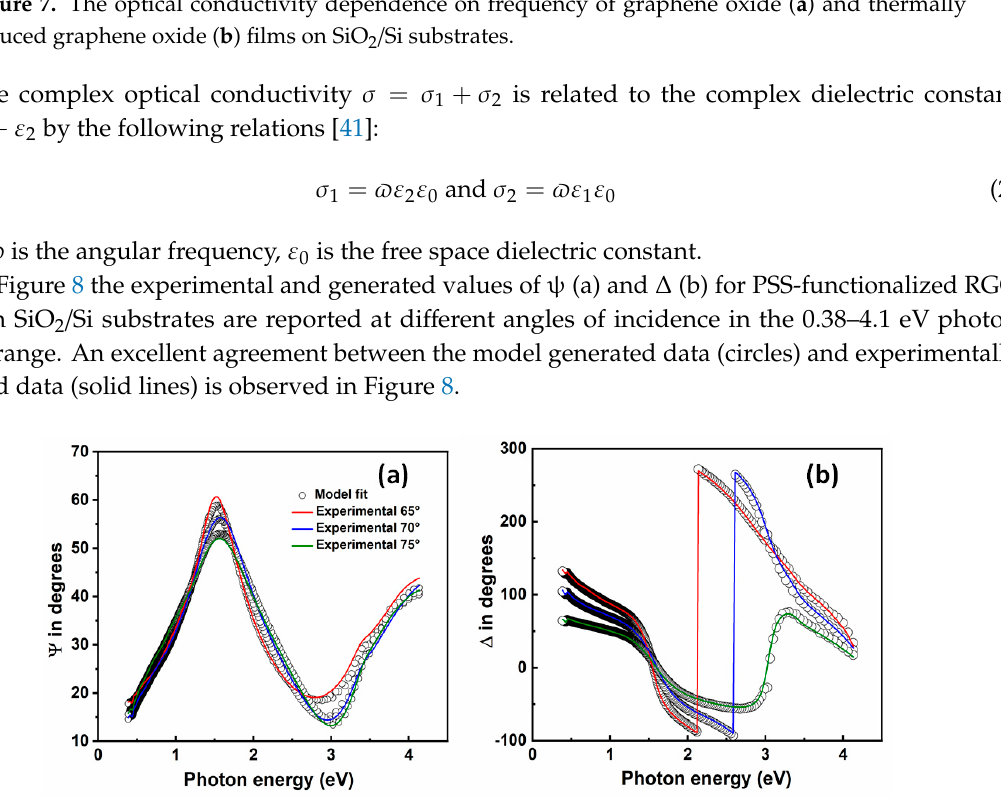
Table 2. Lorentz oscillators and pole parameters for reduced graphene oxide stabilized with poly(sodium 4-styrenesulfonate) on SiO 2 /Si substrates. Amplitude 𝐴 (cid:3038) has a unit of eV 2 , center energy 𝐸 (cid:3038) and broadening 𝛤 (cid:3038) have units of eV; d is the thickness of film in nm; the high-frequency dielectric constant dielectric constant 𝜀 (cid:2998) is dimensionless.